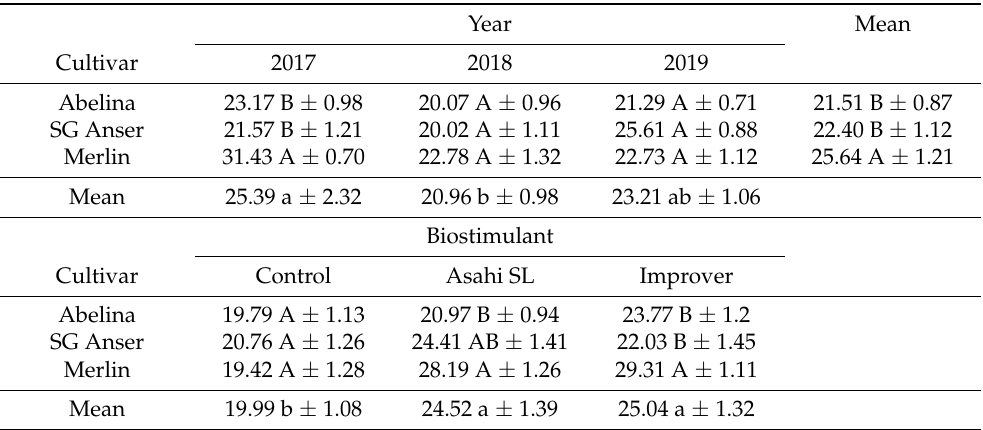
Table 6. Pod number per plant according to years, cultivars, and biostimulants. Year